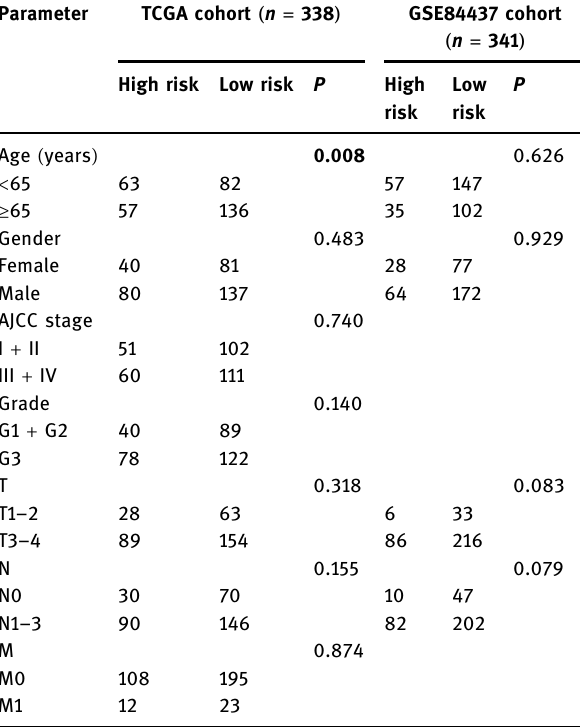
Statistic: between - groups comparison using the chi - square test. Bold values indicate P <